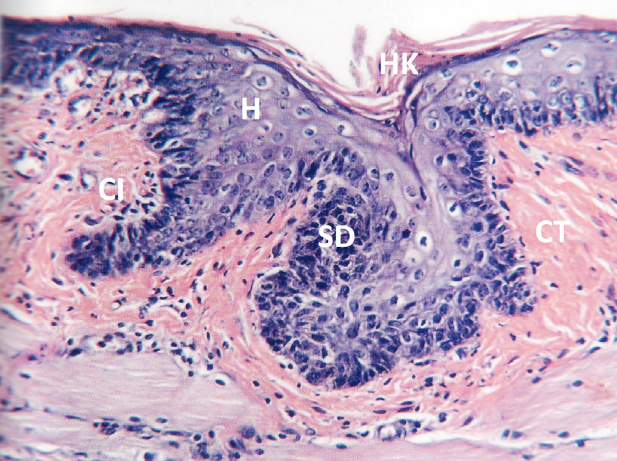
from an animal treated for 6 weeks with 7,12-dimethylbenza[a] anthracene (DMBA). Focal epithelial hyperplasia (H), hyperkeratiniza- tion (HK) and severe epithelial dysplastic changes (SD) are evident. The connective tissue (CT) looks more fi brous with moderate in fl ammatory cell in fi ltrate (CI). Magni fi cation: 20 (cid:1) .